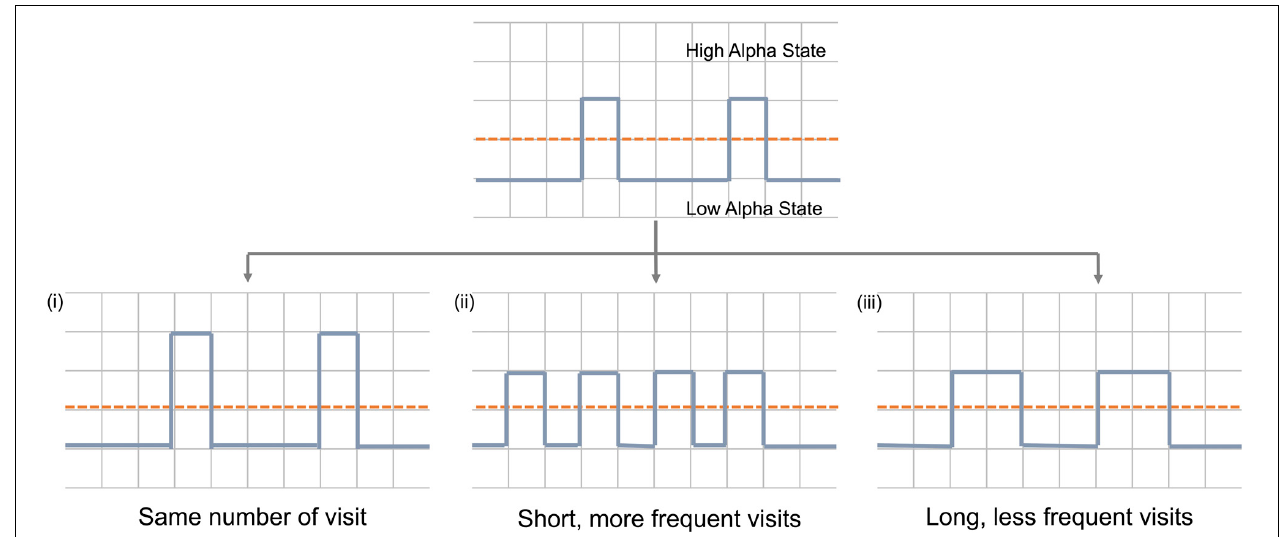
FIGURE 1 | Schematic representation of mechanisms by which alpha power can increase during neurofeedback. Dashed red line represent pre-set threshold defining the states and solid blue line represents alpha power during neurofeedback. Y-axis represents time and x-axis represents alpha power.